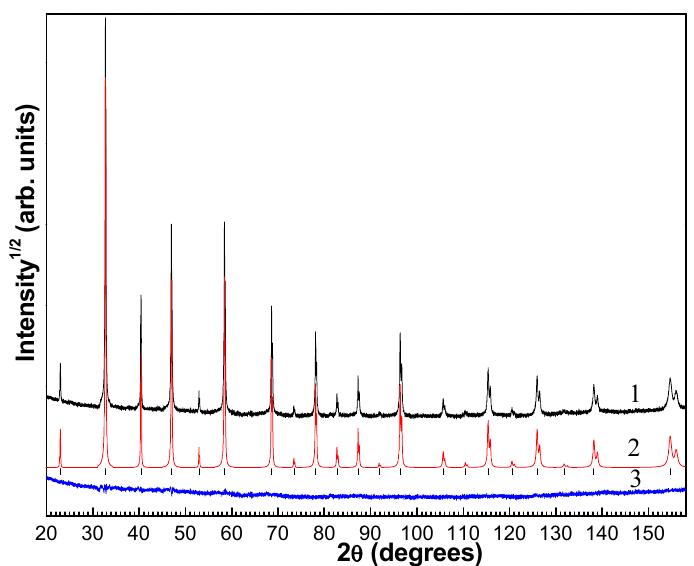
Figure 1. Experimental (1), calculated (2), and difference (3) X-ray diffraction patterns of the Gd 0.2 Sr 0.8 FeO 2.79 compound after DDM refinement. Table 1. Atomic positions, and their occupancies and thermal parameters in the crystal structure of Sr 0.8 Gd 0.2 FeO 2.79 . Space group is Pm3m, with lattice parameter a = 3.8688(1) Å.